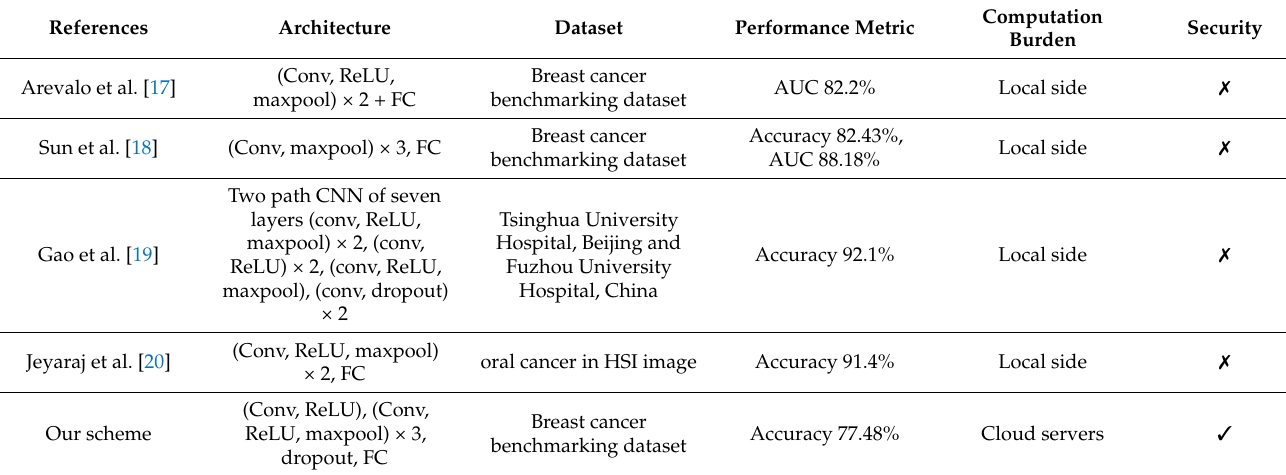
Table 1. A summary of CNN applications in medical image